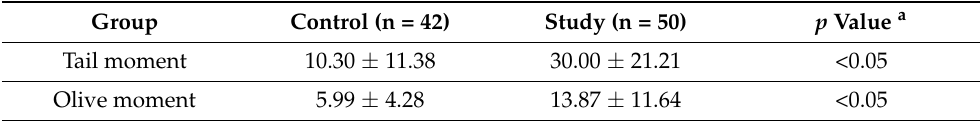
Table 2. Tail and olive moment levels of the control and the study